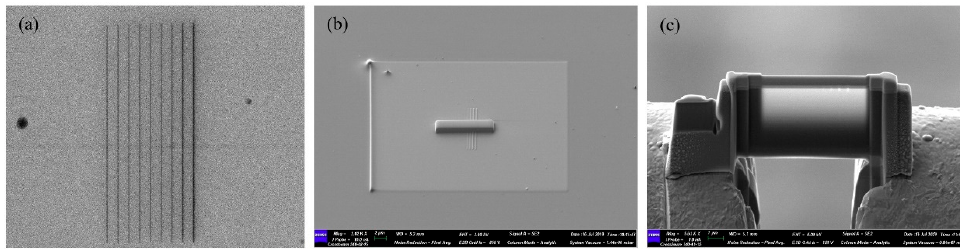
Figure 2. The process of fabrication and preparation of cross-sections of bulk silicon scanned by He- FIB with line doses of 0.003, 0.0045, 0.006, 0.0075, 0.01, 0.02, 0.03, 0.04 and 0.05 nC/ μ m at beam energy of 25 keV: ( a ) Helium ion microscope image of bulk silicon scanned by He-FIB; ( b ) Image of bulk silicon after platinum layer deposited by FIB; ( c ) The lamella welded on the copper grid.